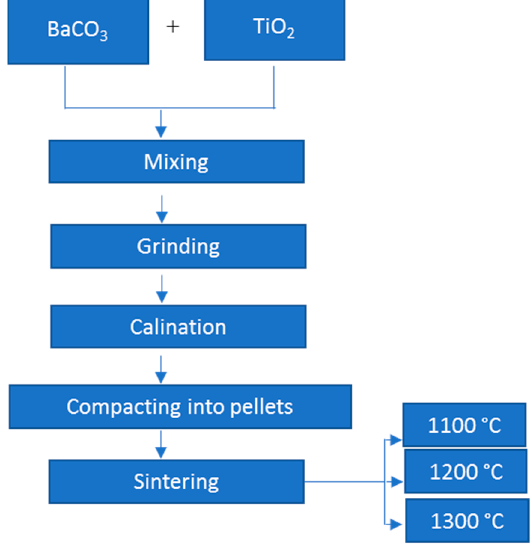
Figure 1. Schematic illustration of the synthesis protocol of the BaTiO 3 ceramics.